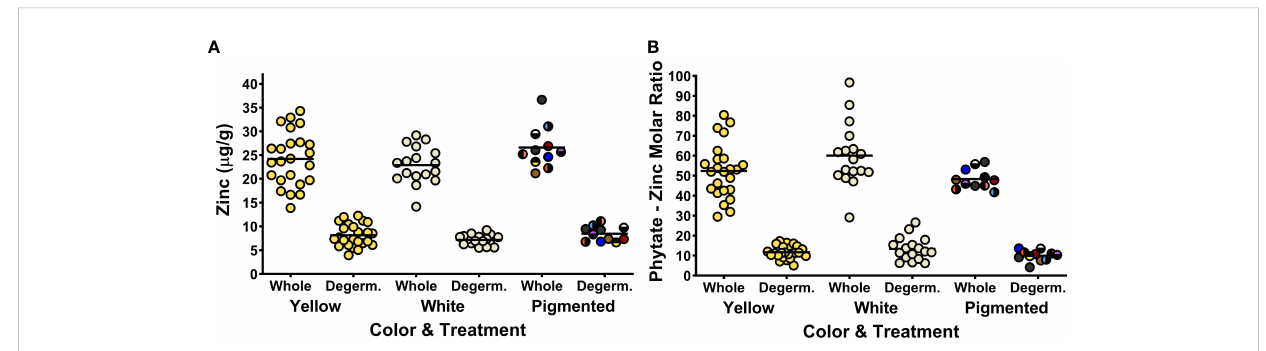
FIGURE 3 Dot plots depicting zinc concentrations (A) and phytate:Zn molar ratios (B) of the 52 maize genotypes in the Maize Nutrition Panel before (whole) and after removing the germ fraction (degerminated). Each dot represents the mean value of two measurements from each genotype. Zinc concentrations are measured as micrograms per gram of cooked, lyophilized and milled maize sample (dry weight). The circle color of pigmented maize represents the bran color pattern of each